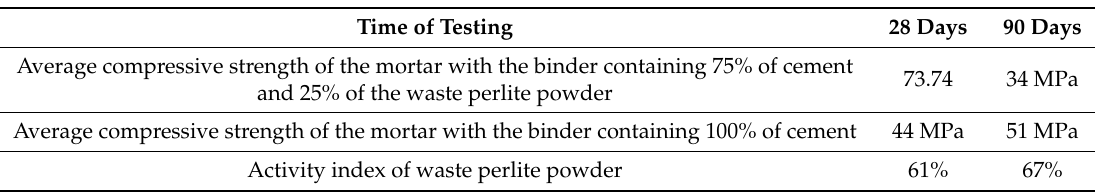
Table 3. Activity index of the waste perlite powder.